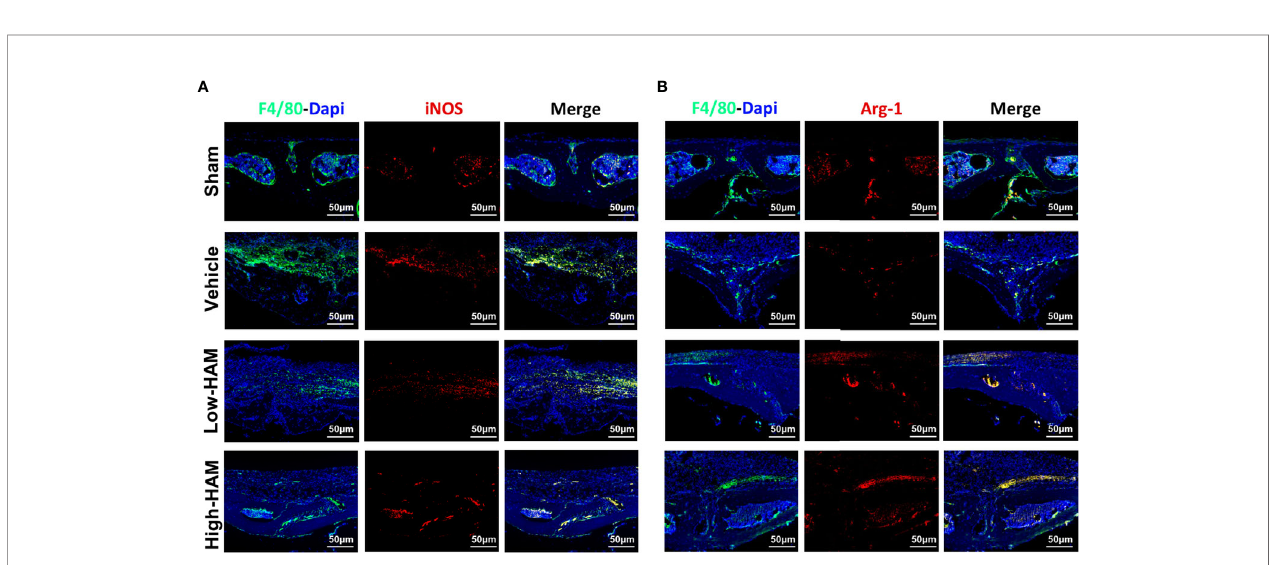
FIGURE 3 | Harmine treatment shifted the polarization of macrophages from M1 to M2 in PPO. Representative immuno fl uorescent staining images for (A) iNOS (M1 marker) and (B) Arg-1 (M2 marker). Scale bar indicates 50 m m. n =